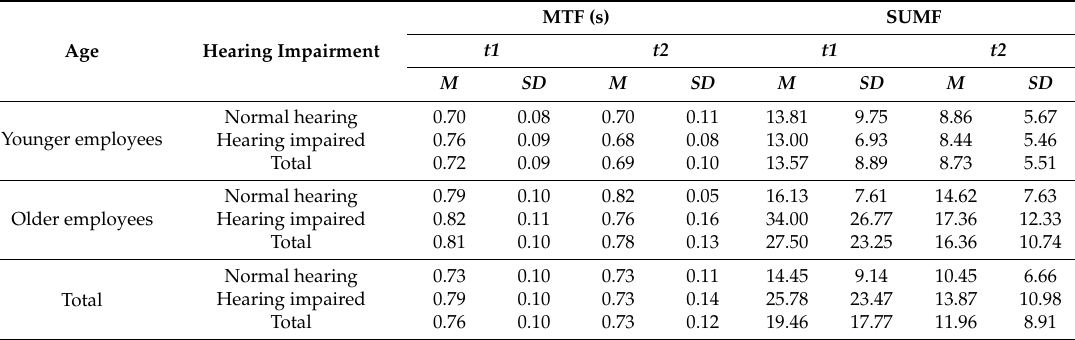
Table 2. Descriptive statistics—long-term selective attention and concentration. Age